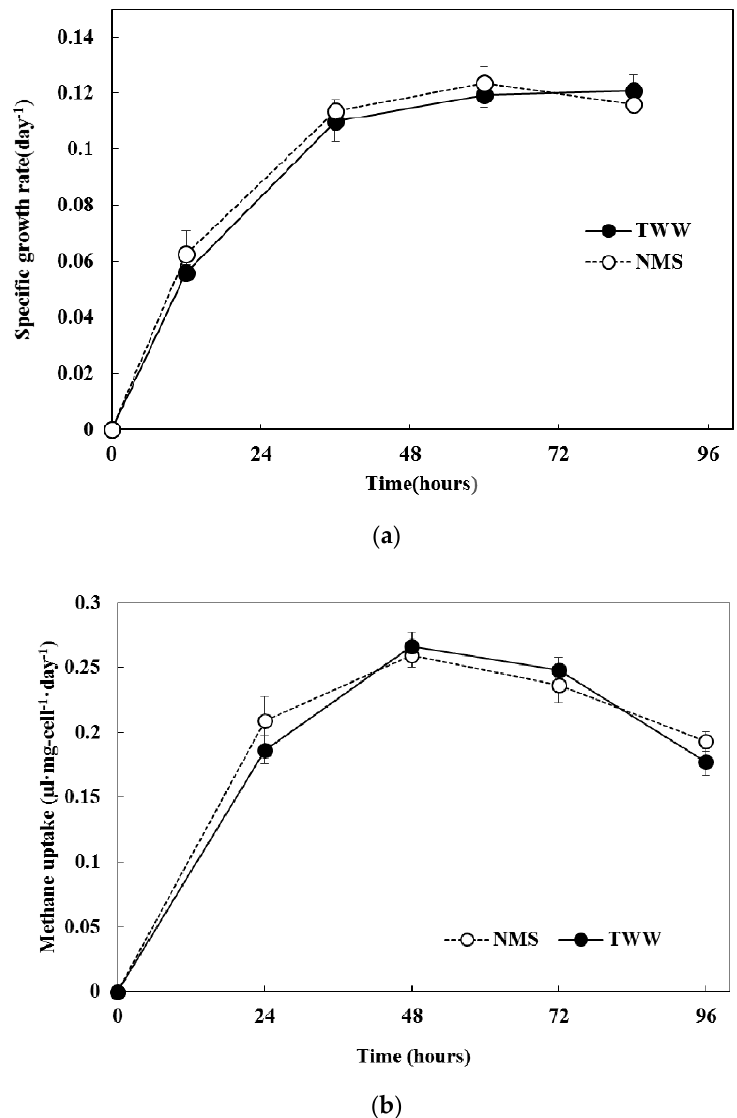
Figure 3. Comparison of the methanotroph-specific growth rate ( a ) and methane uptake rate ( b ) in NMS medium and TWW supplemented with nitrate and phosphate.